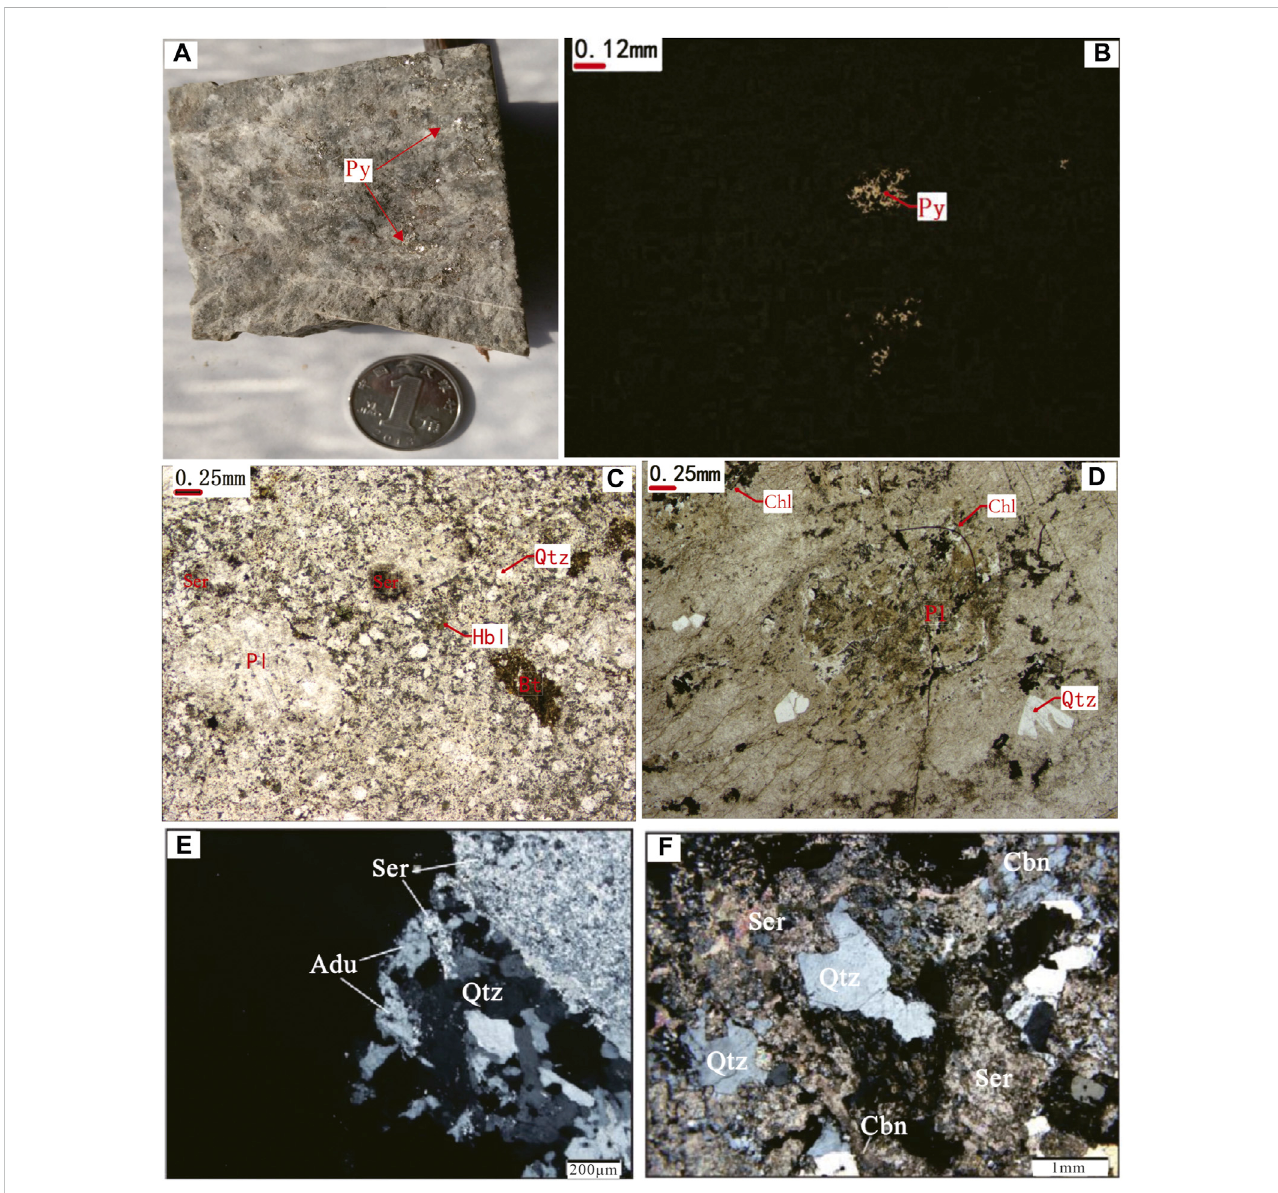
FIGURE 4 Mineralized, altered and microscopic characteristics of surrounding rocks in the study area (E, F modi fi ed from Li, 2021) . (A) Hand specimen of pyritic dacite; (B) Microscopic characteristics ofpyrite inpyrizeddacite; (C) Microscopic characteristics ofsericite insyenogranite; (D) Microscopic characteristics of chlorite in syenogranite; (E) Microscopic characteristics of feldspar and sericite inpyriticsericite; (F) Microscopic characteristics ofsericite and carbonation in granodiorite. Abbreviations: Py, Pyrite; Ser, Sericite; Hbl, Hornblende; Chl, Chlorite; Adu, Adularia; Cbn, Carbonate mineral; Bt, Biotite; Pl, Plagioclase; Qtz,